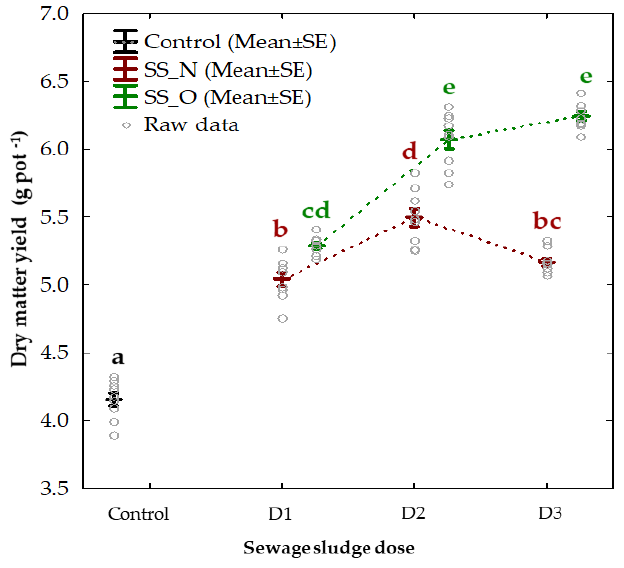
Figure 2. Dry matter yield of aboveground parts of maize plants relative to the dose and type of sewage sludge. Mean values ( n = 9) ± standard error. Identical superscripts denote no significant ( p > 0.05) differences between the experimental variants according to the post hoc Tukey HSD test .